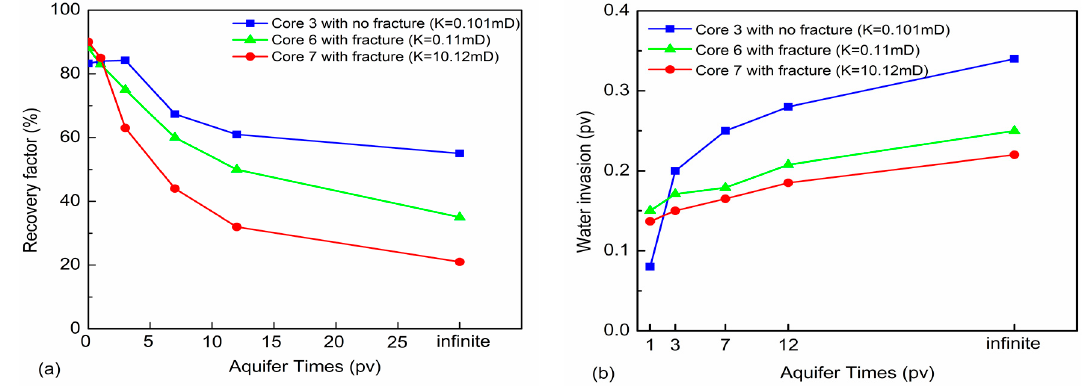
Figure 9. Recovery factor and water invasion versus aquifer times for different fractures. ( a ) Recovery factor; ( b ) water invasion.